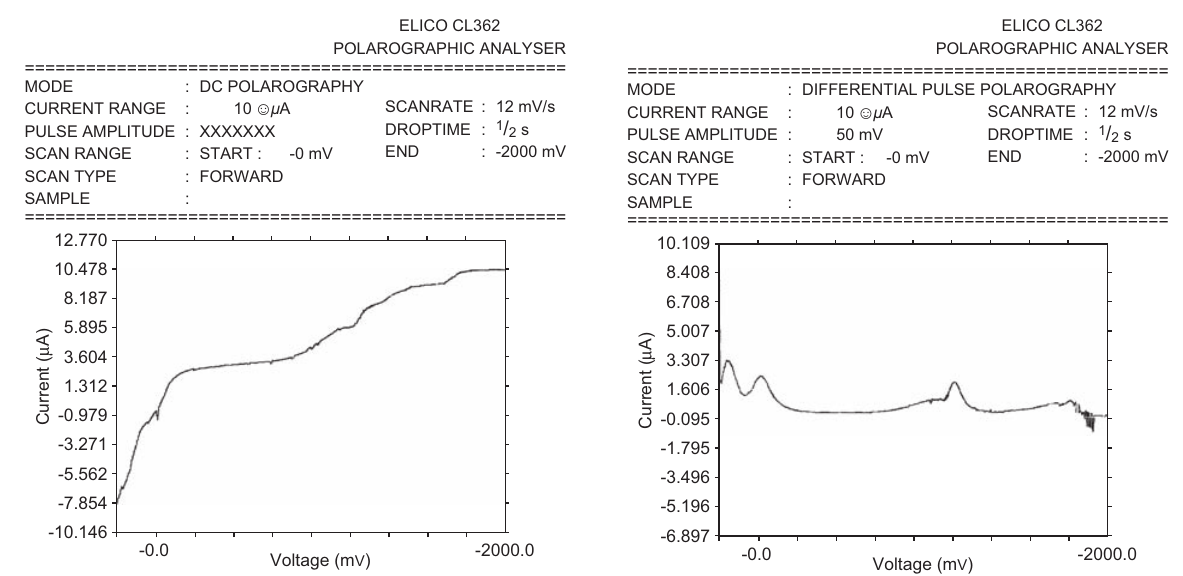
Figure 1 Direct current polarogram and differential pulse polarogram of coumarin (0.2 m m ) in ammonium tartrate (0.2 m ) pH 8.2 ± 0.1.